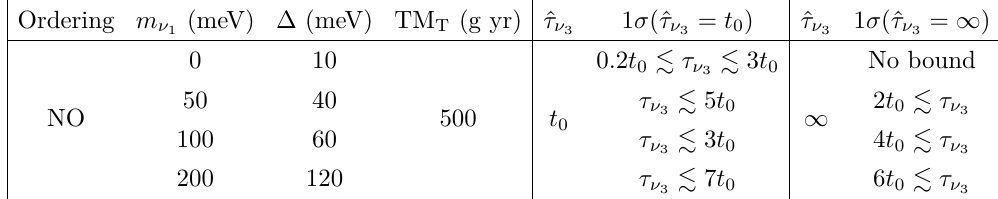
at 1 σ confidence level for ν 3